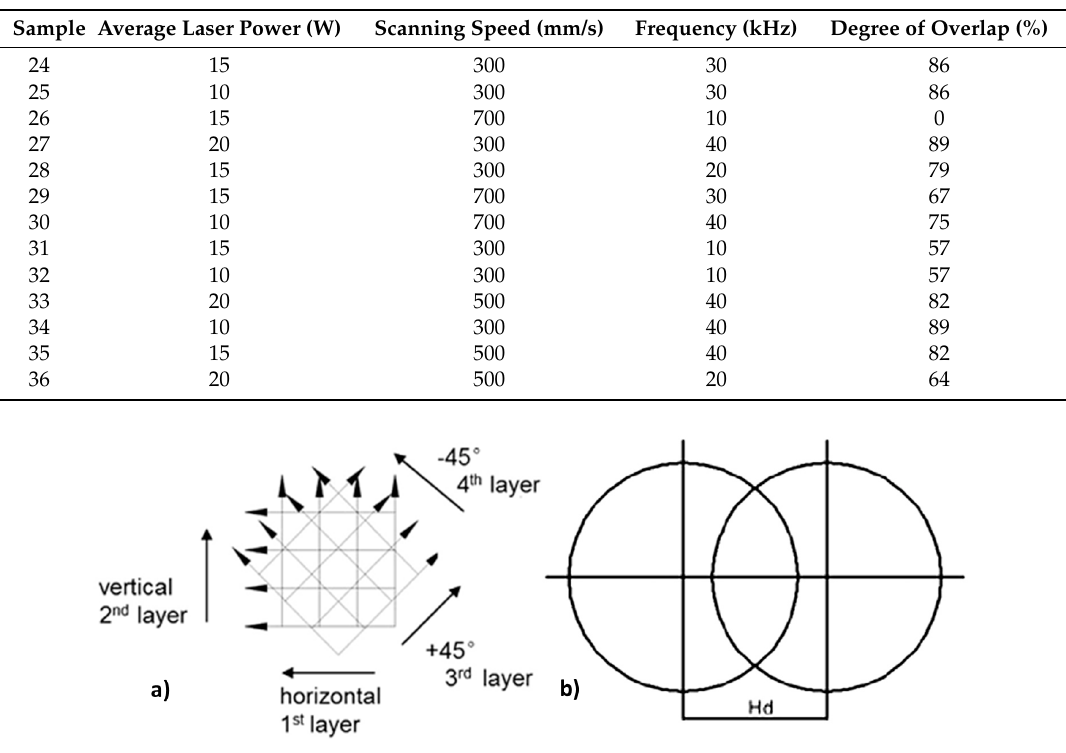
Figure 2. ( a ) Schematic representation of the employed scanning strategy; ( b ) Hatch distance between two consecutive laser pulses.